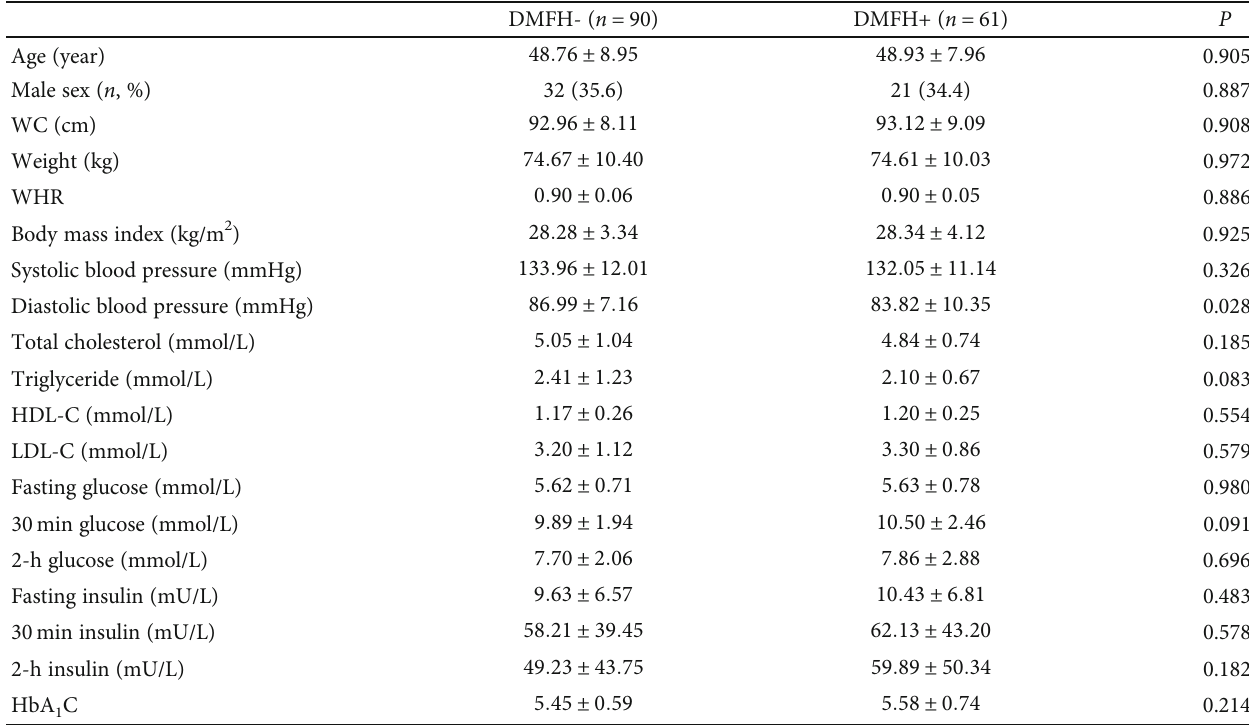
Table 1: Baseline clinical characteristics of the participants based on the history of